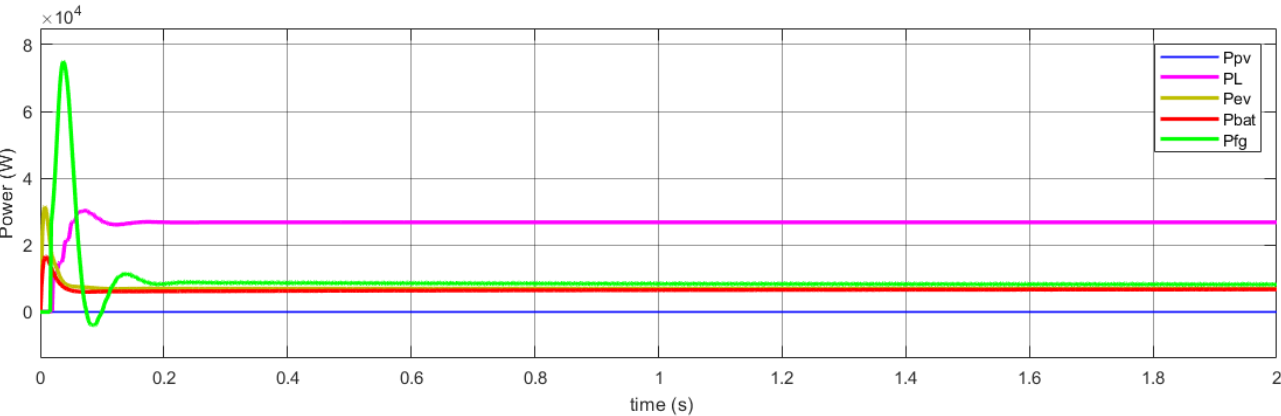
Figure 10. Power distribution in the system.